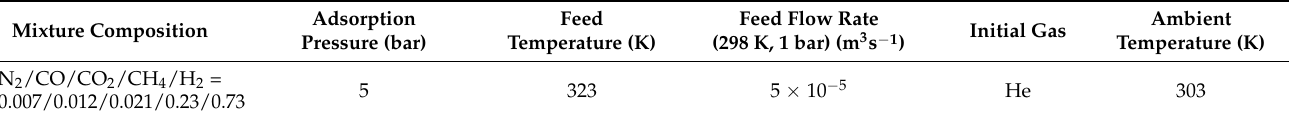
Table 3. Operating conditions used in the adsorption process